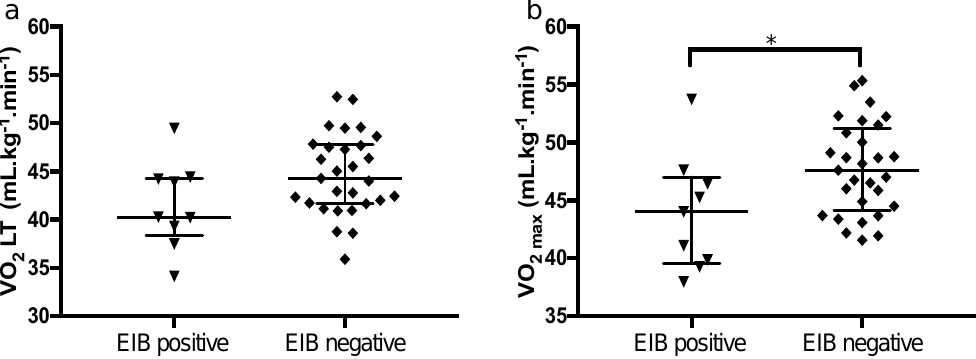
Figure 3. Comparison of aerobic capacity between groups. ( a ) oxygen consumption in lactate threshold ( p = 0.06). ( b ) maximal oxygen consumption ( p = 0.03). * < 0.05.